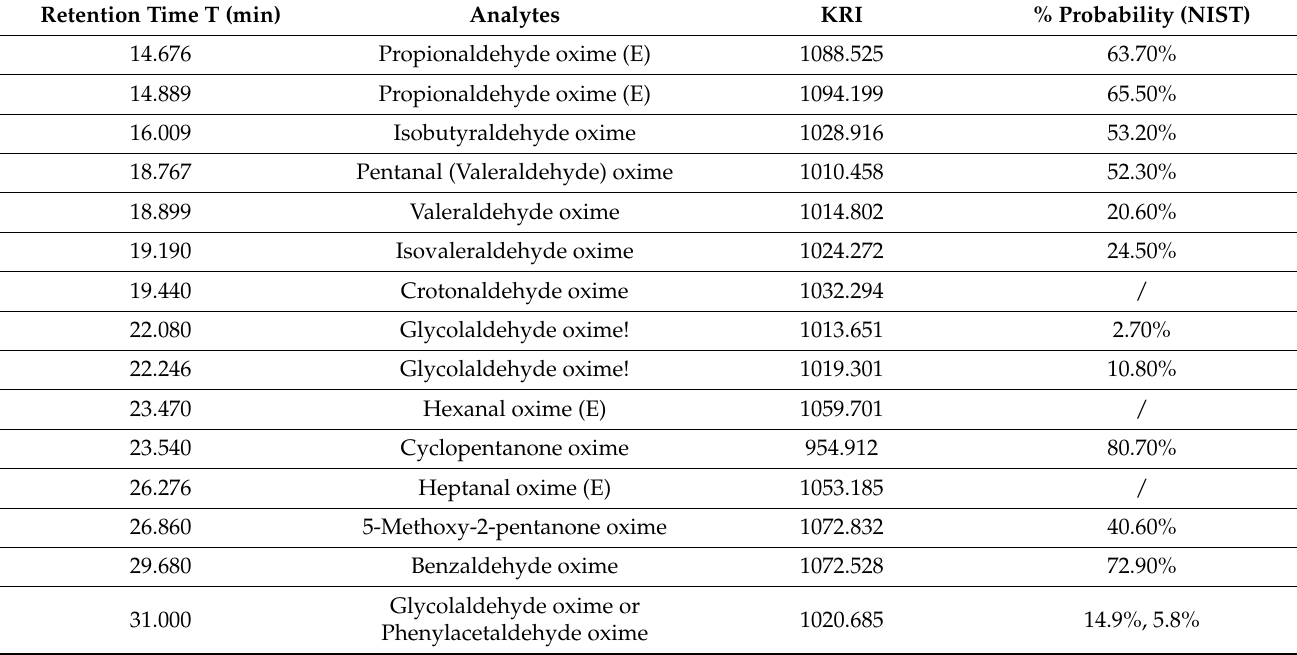
Table 6. Identification of carbonyl compounds in overcooked chicken meat aqueous extract extracted by HS-SDME on PFBHA droplet, based on RT, KRI, and fragmentation.